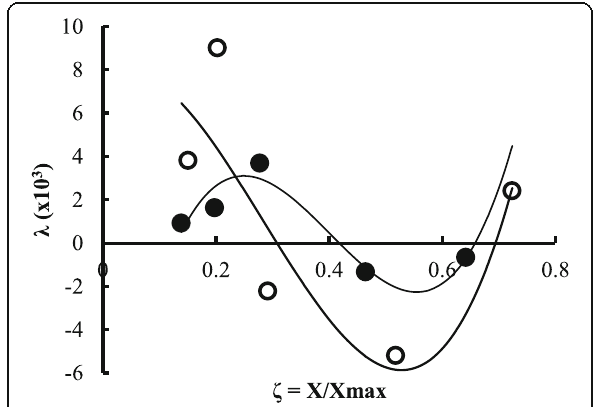
Fig. 4 Shape of production curve and presence of product breakdown of exo -polygalacturonase at a function of various levels of relative biomass production, ζ = X/X max in submerged ( ○ ) or solid-state fermentation ( ● ) of P.